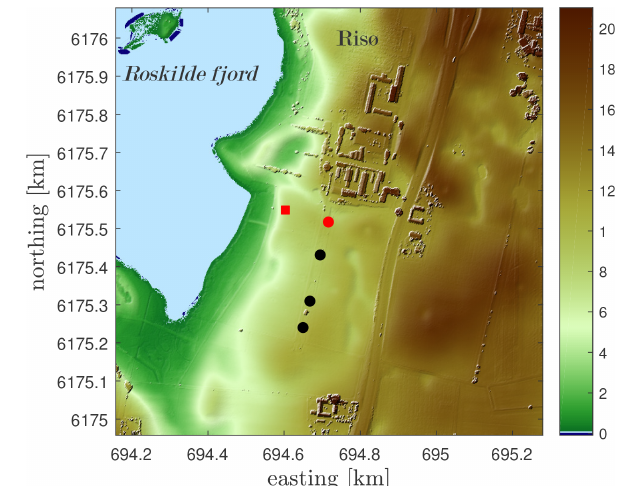
Figure 2. The Risø test site in Roskilde, Denmark, on a digital sur- face elevation model (UTM32 WGS84). The V52 meteorological mast is shown in a red square. The wind turbines are shown in cir- cles (in red the reference V52 wind turbine). The color bar indicates the height above mean sea level in meters.